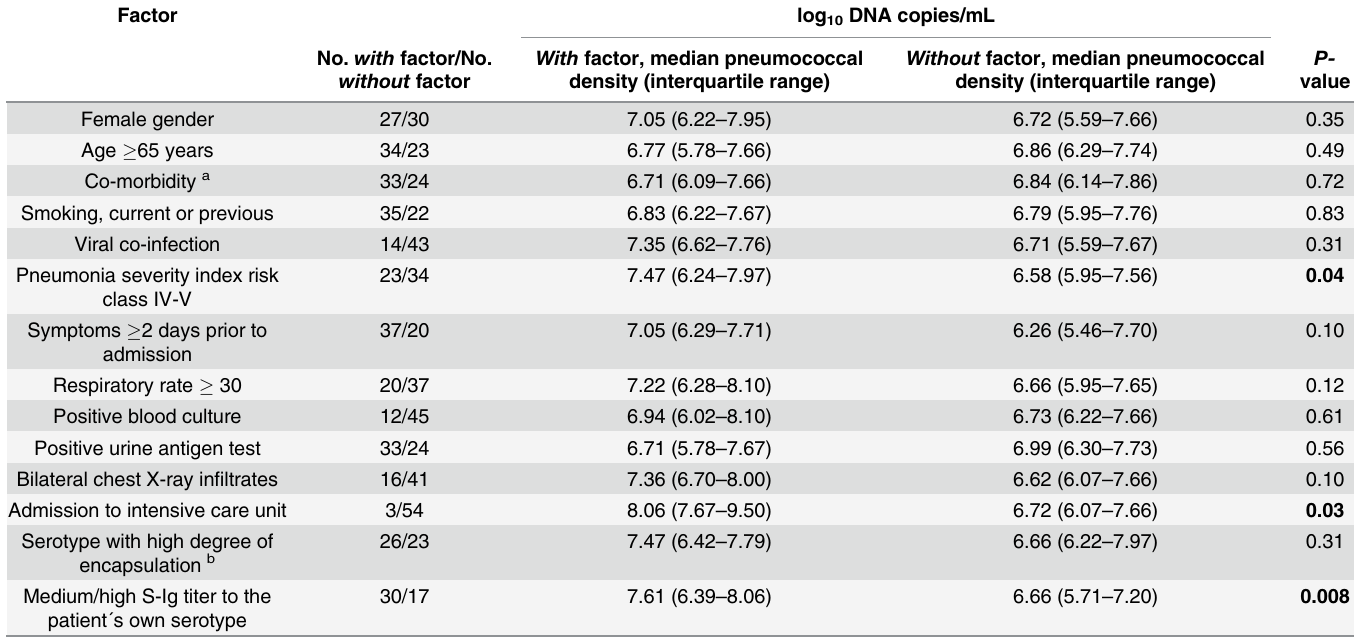
Table 2. Clinical and microbiological factors and their association with nasopharyngeal pneumococcal density. Univariate analysis on 57 patients if not otherwise stated. Factor log 10 DNA copies/mL With factor, median pneumococcal Without factor, median pneumococcal P- No. with factor/No. without factor density (interquartile range) density (interquartile range)